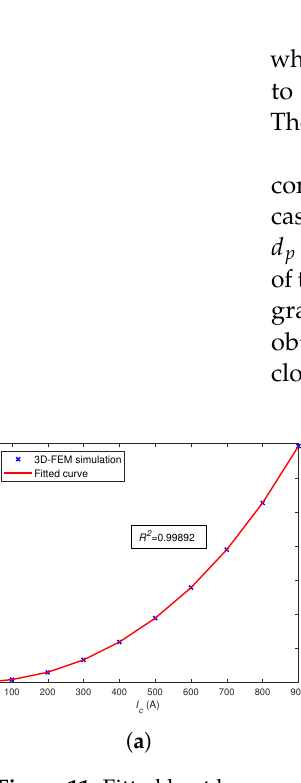
Figure 11. Fitted heat loss curves of Cable 1H: ( a ) conductor; ( b ) shield; ( c ) armor (values of the coefficient of determina- tion R 2 included).